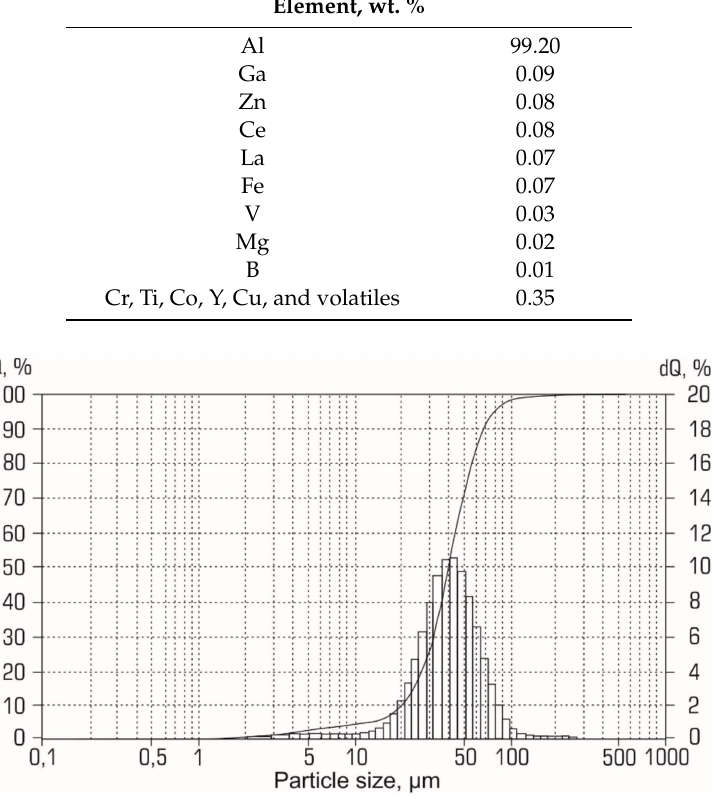
Figure 2. Size distribution curve for the initial aluminum powder.